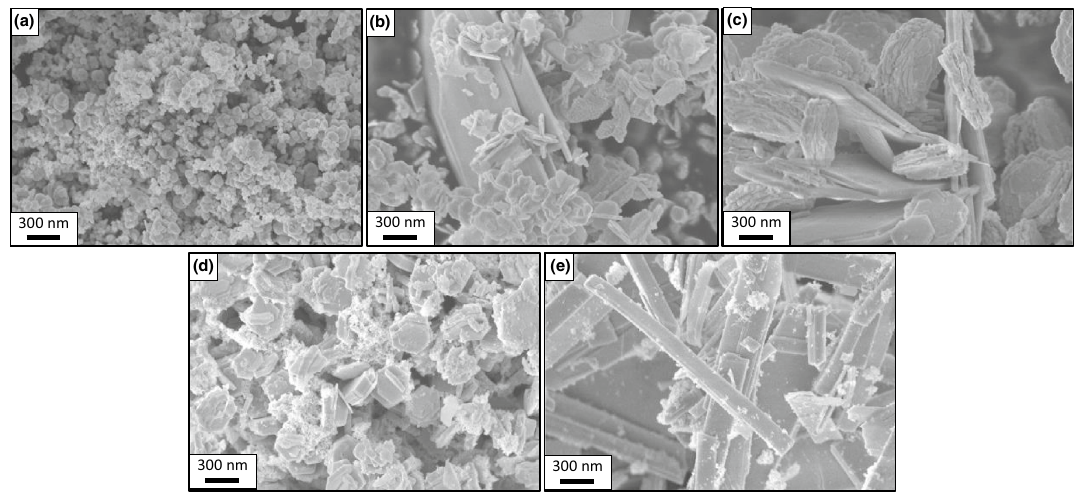
Fig. 1 FESEM images of bismuth sulfides synthesized in the mixture of ethanol and distilled water with their volume ratio of 1:0 ( a ), 2:1 ( b ), 1:1 ( c ), 1:2 ( d ), and 0:1 ( e